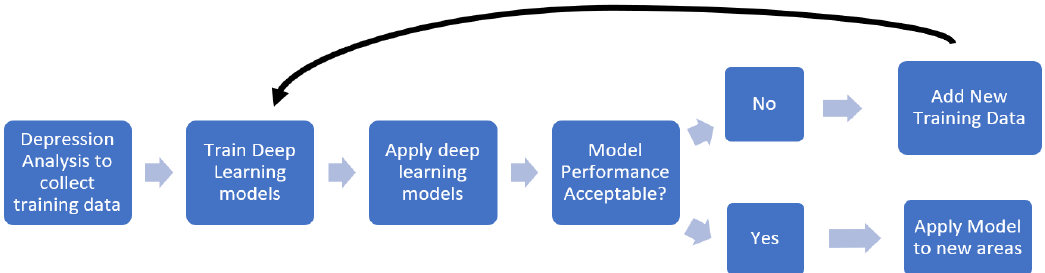
Figure 2. Workflow of automated analysis of LiDAR for the detection of charcoal piles.